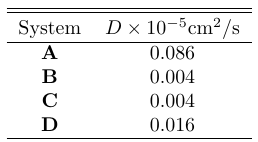
Table 2: Diffusion coefficient values of